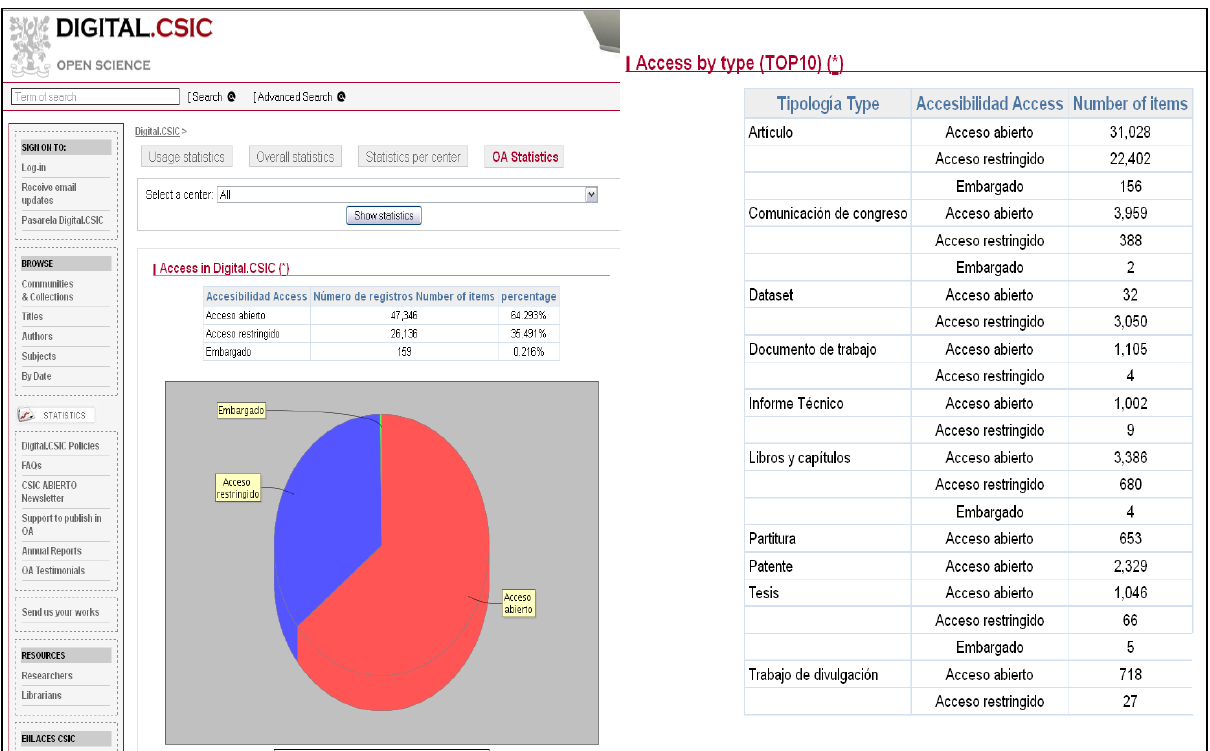
Figure 4. Openness degree at DIGITAL.CSIC and by item typologies. Source: DIGITAL.CSIC OA